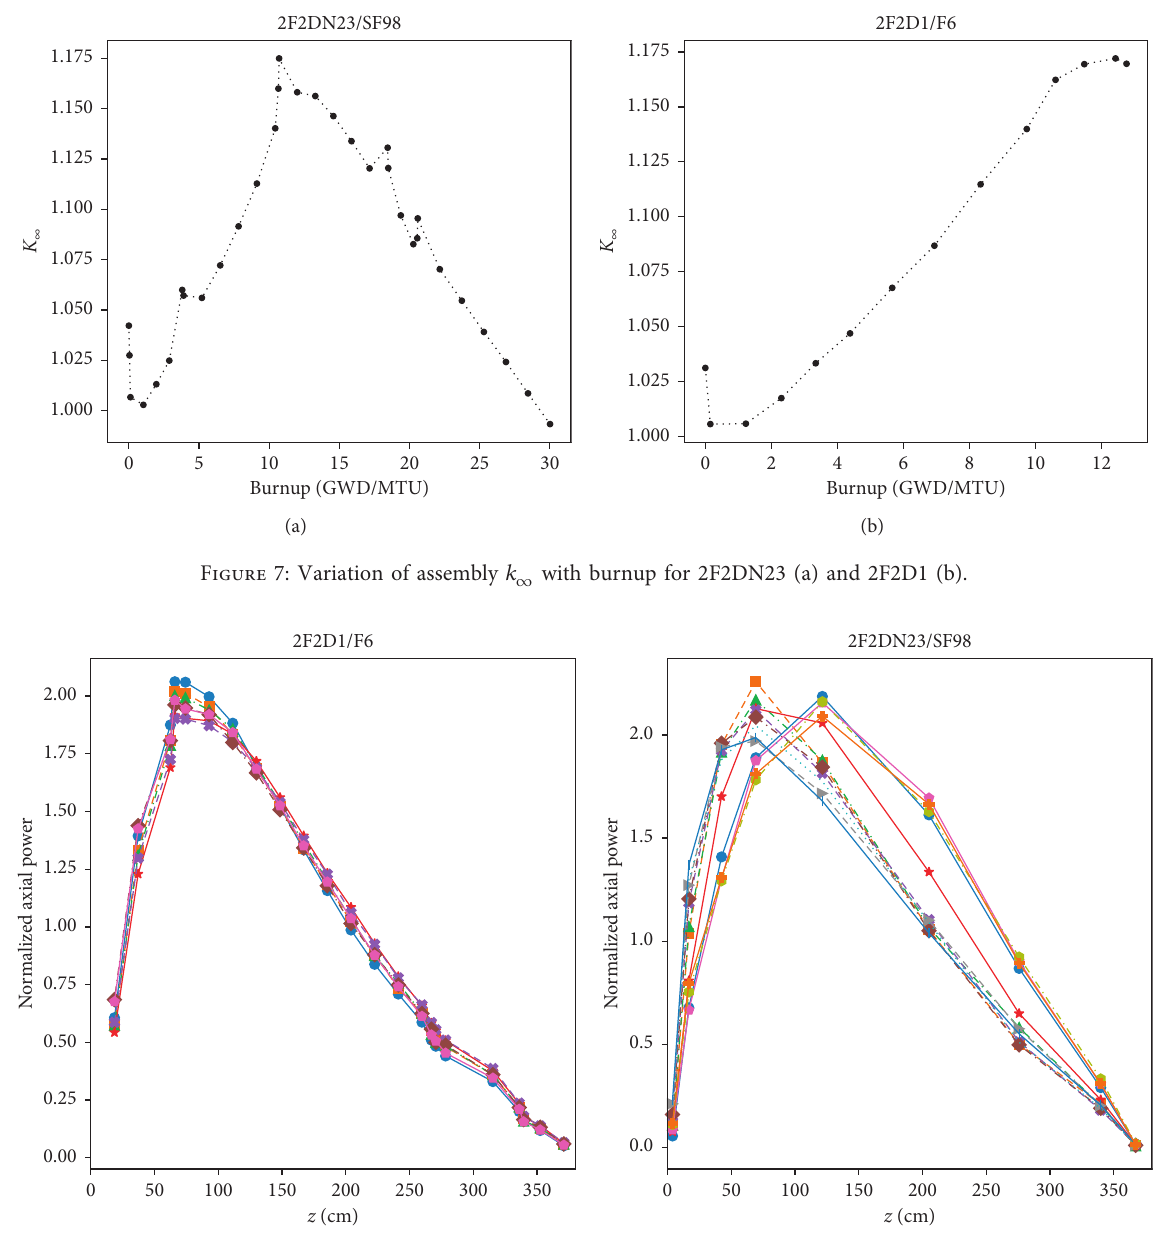
Figure 8: Variation of the axial power profile with burnup for the SF98 rod (a) and F6 rod